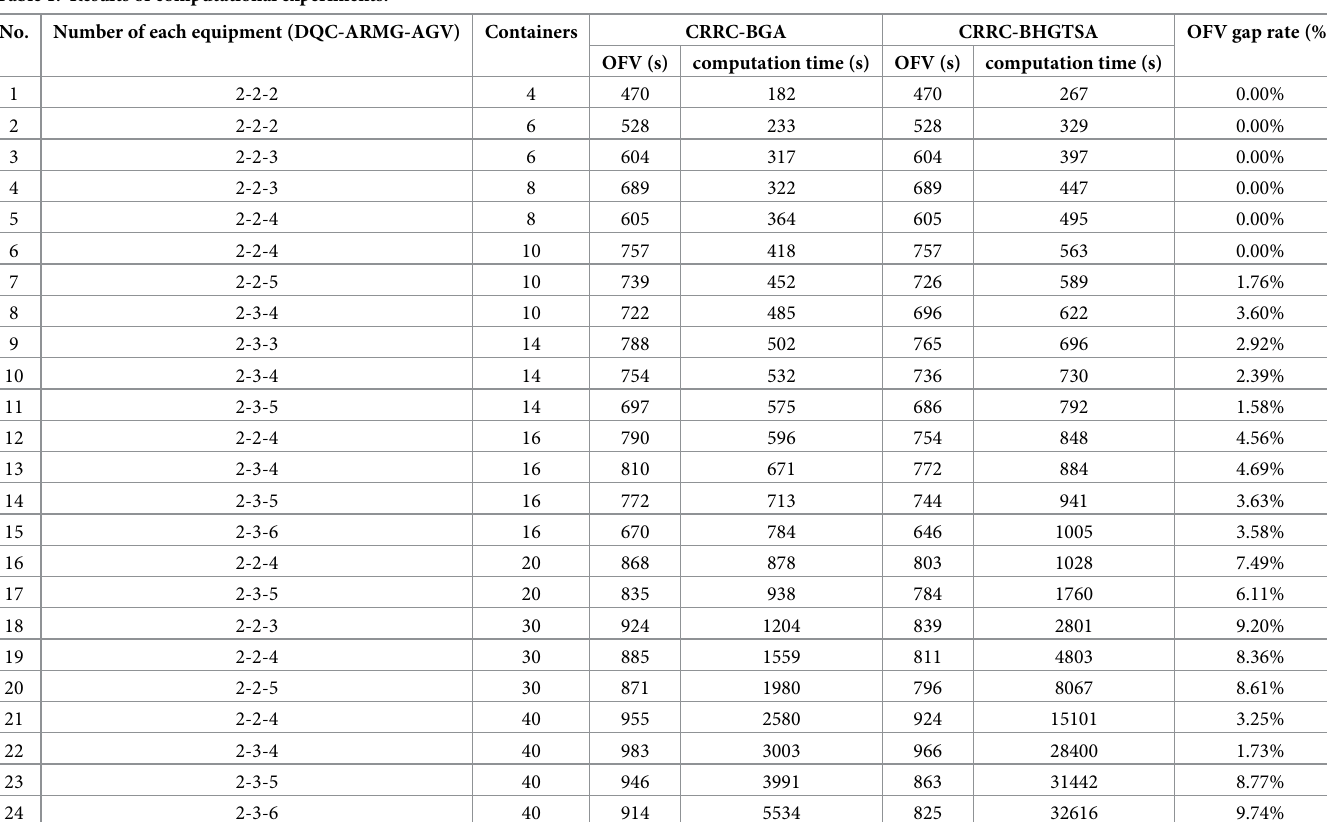
Table 1. Results of computational experiments. No. Number of each equipment (DQC-ARMG-AGV)